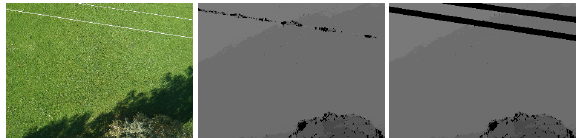
Figure 14. Generated depth maps: The left image shows the reference input image, the middle one the erroneous depth map that contains wrong depth measurements in the vicinity of power lines and the right one the filtered depth map used for fusion.